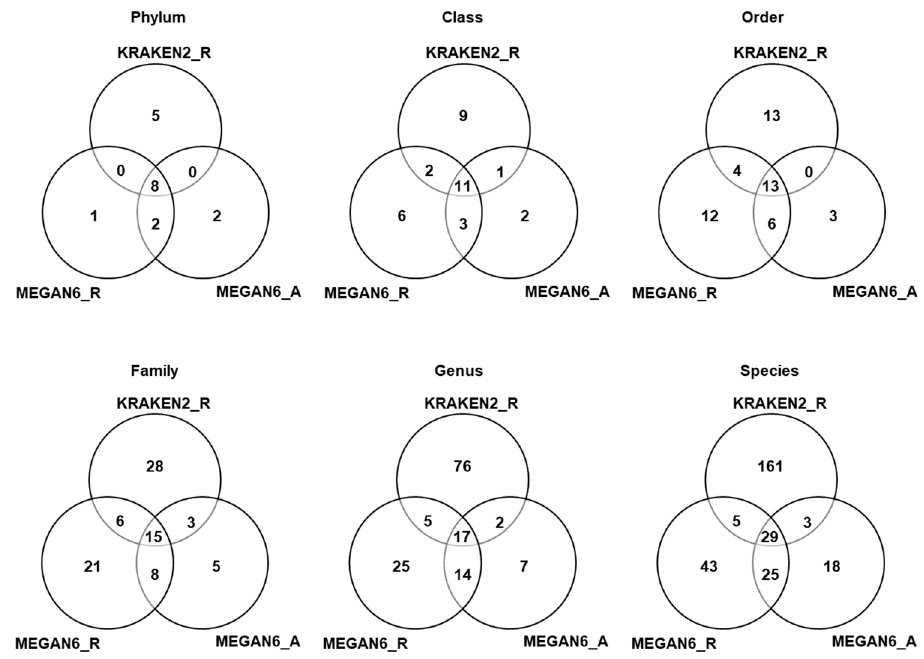
Figure 7. Comparison of identified microorganisms at different taxonomy levels (i.e., phylum, class, order, family, genus, and species) by three different analytical methods (i.e., KRAKEN2_R, MEGAN6_R, and MEGAN6_A).